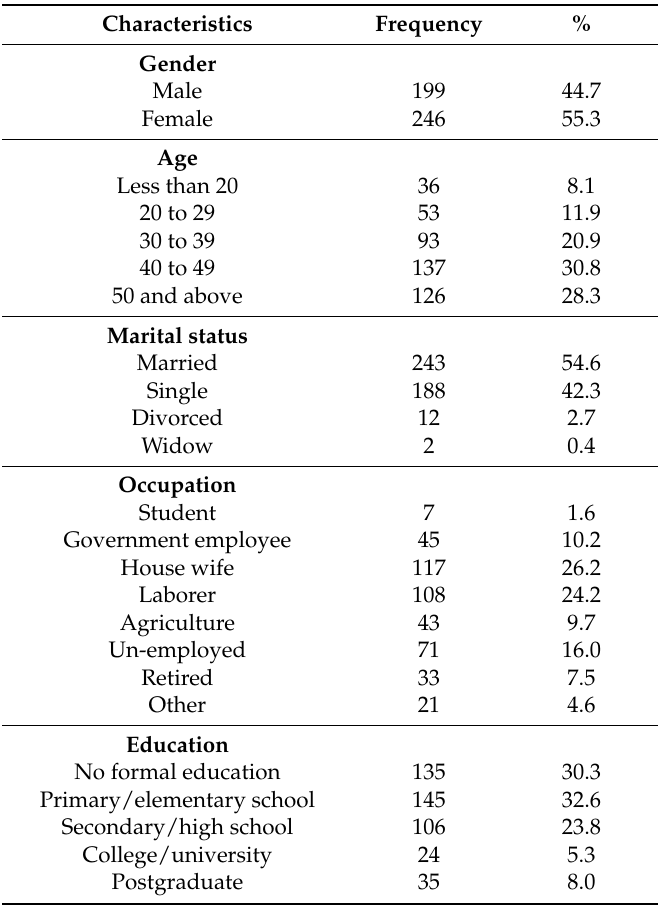
Table 3. Demographic